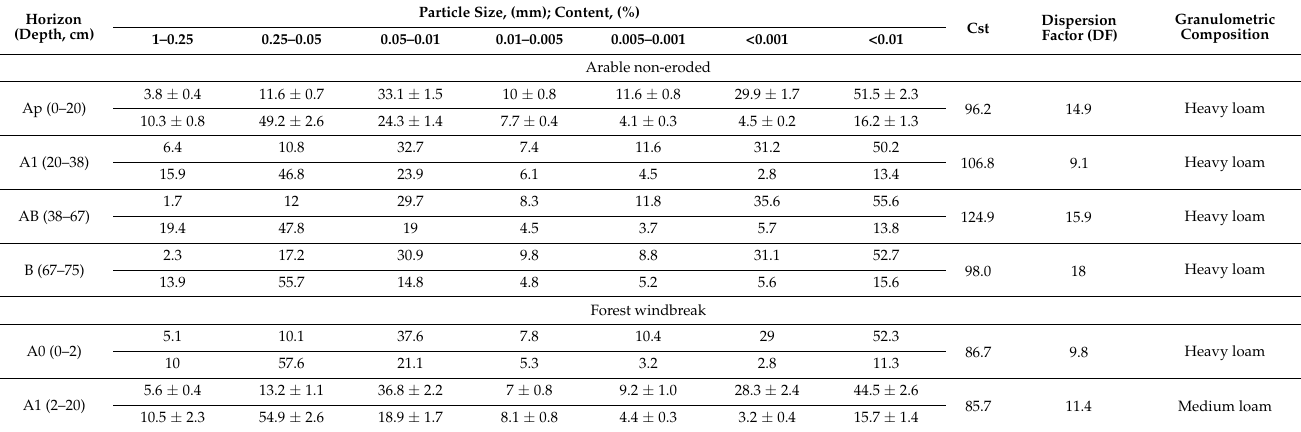
Table 3. Particle size distribution of soils (mean + SD) 1 .